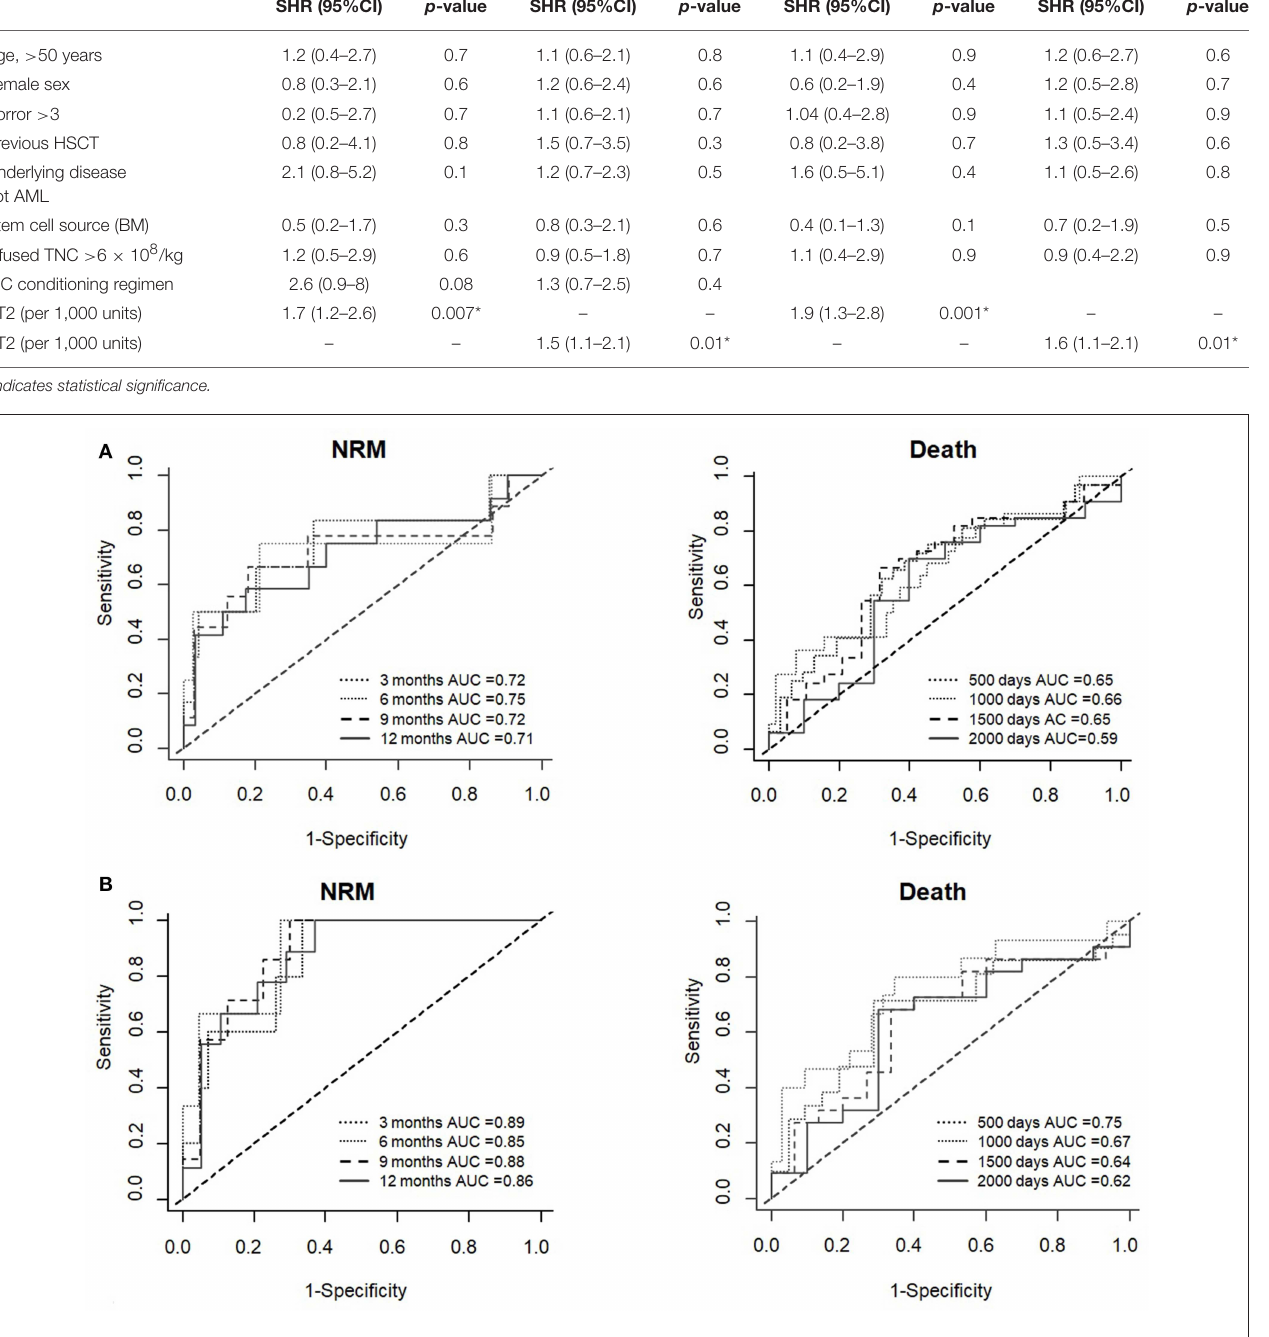
were not fully comparable with ours, since none of them included patients with haplo-HSCT or used PTCy as GVHD prophylaxis. In most of them, donors were HLA-identical